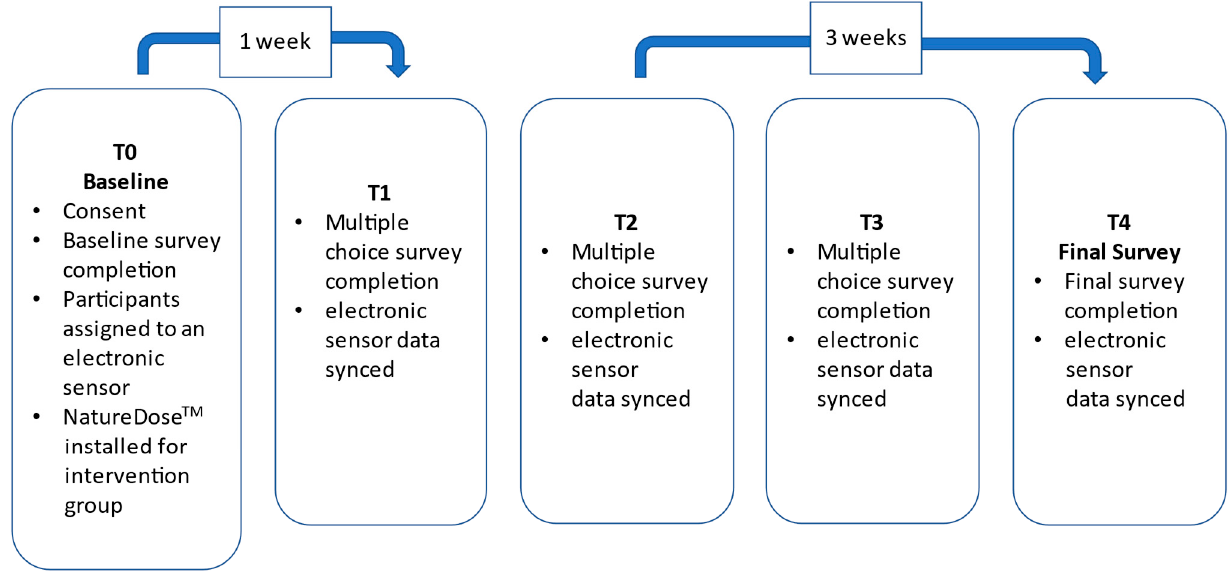
Figure 1. Data collection